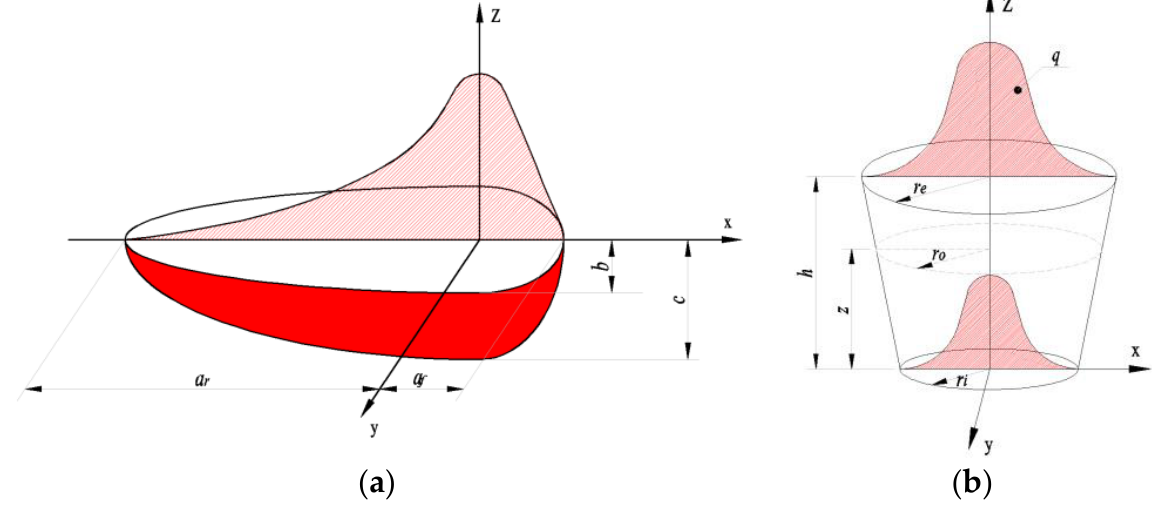
Figure 6. Heat source model of welding process (unit: mm). ( a ) Double-ellipsoidal heat source model. ( b ) Cone heat source model.